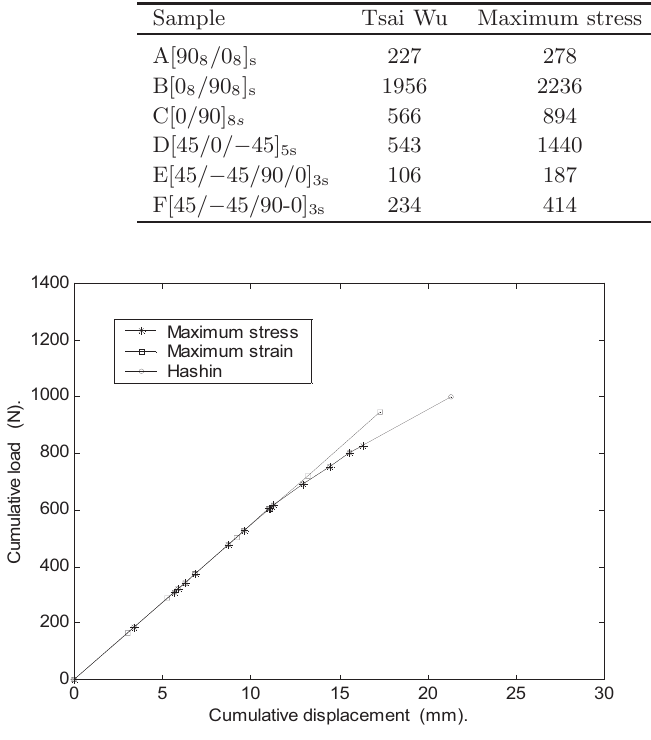
Fig. 5. Cumulative macroscopic curves of the test sample E with the limited discount method (matrix stiffness un-